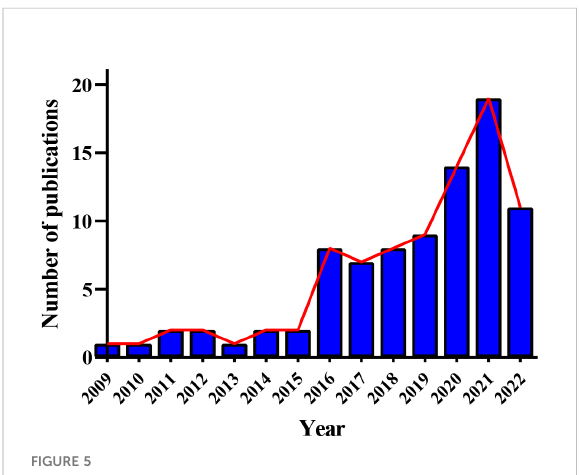
FIGURE 5 Annual publication trend of metabolomic studies in diabetic retinopathy. Eighty-seven relevant articles were obtained by searching the Web of Science and PubMed before 30 April 2022, with search terms: “ diabetic retinopathy ” AND ( “ metabolomics ” or “ metabonomics ” or “ metabolic pro fi ling ” or “ metabolome ”